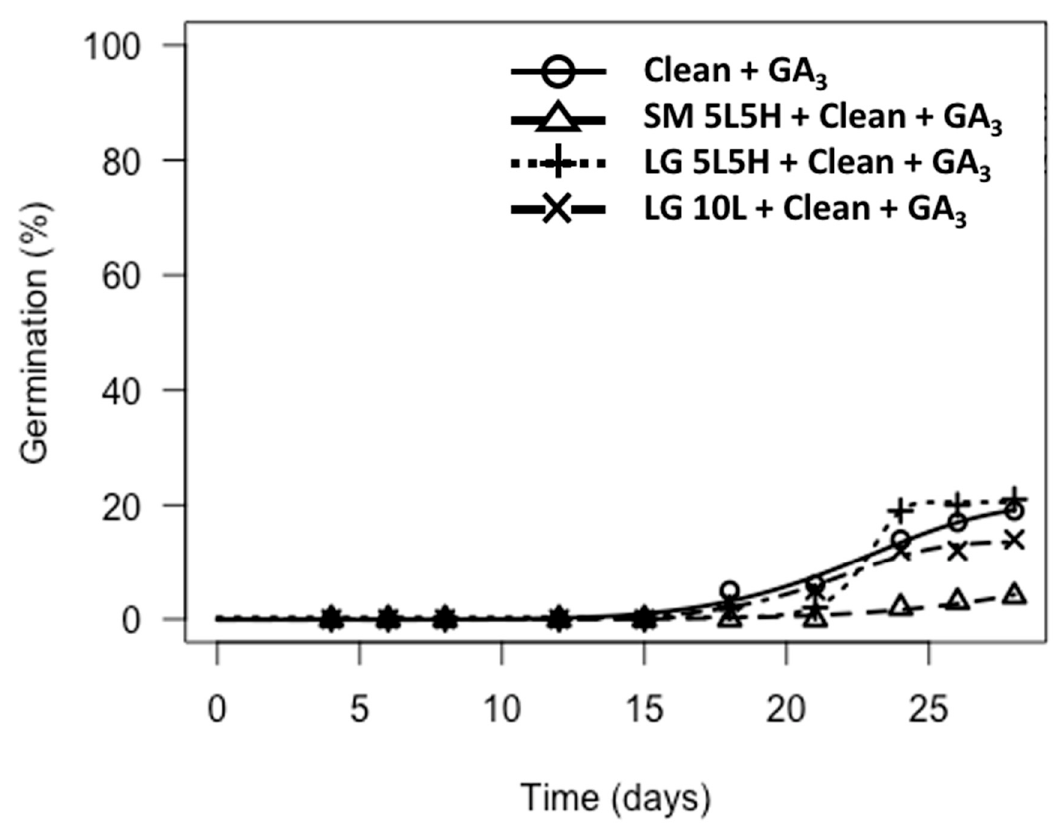
Figure 3. Germination of A. turbinatus over time for treatments that included cleaning to seed and testing on GA 3 -agar (“Clean + GA 3 ”) and where germination was present. The following abbreviations are used: Clean = cleaned to seed, GA 3 = tested on GA 3 -agar, SM = small torch, LG = large torch, 5L5H = exposed to a low flaming temperature for 5 min followed by a high flaming temperature for 5 min, 10L = exposed to a constant low flaming temperature for 10 min. Note that treatments that did not include “Clean + GA 3 ” did not produce any germination, nor did the treatment SM 10L + Clean + GA 3 , and are therefore not represented in Figures.